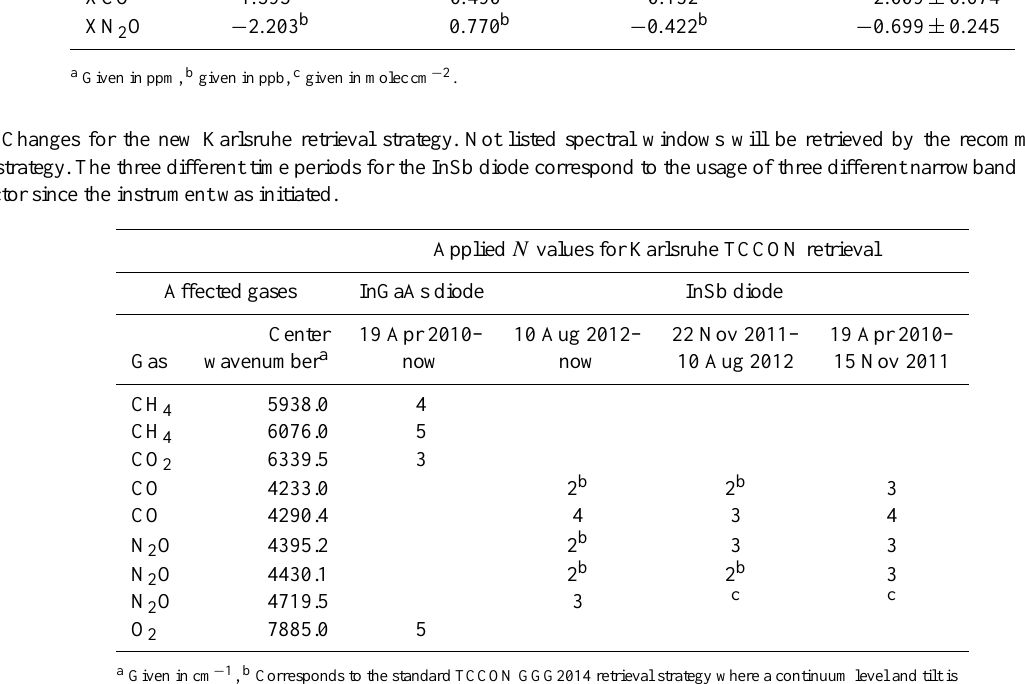
filter 2, one additional spectral window is affected, namely N 2 O (cw: 4395.2) and for filter 1 two more spectral windows are affected, namely CO (cw: 4233.0) and N 2 O (cw: